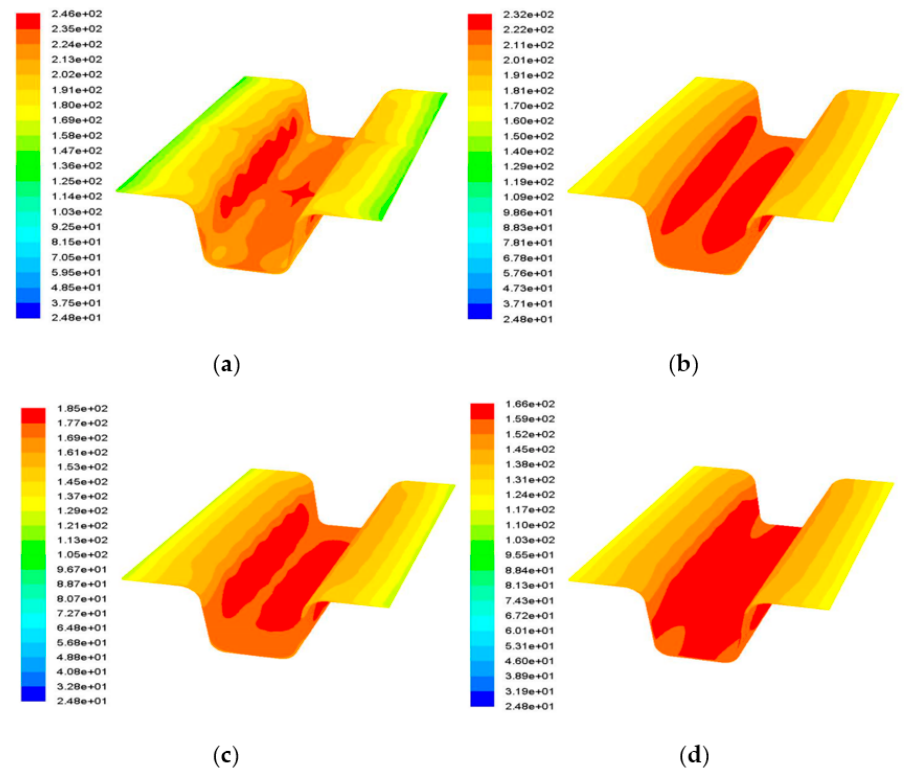
Figure 5. Predicted temperature distribution of the blank at different air flow rates of ( a ) 1m/s, ( b ) 3m/s, ( c ) 7m/s, and ( d ) 10m/s.